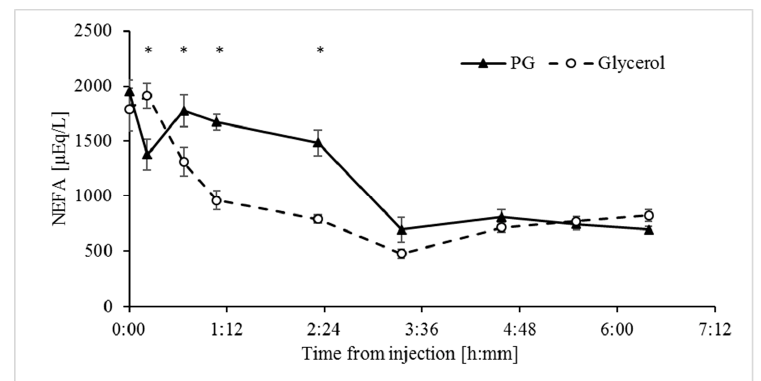
Figure 5. Non-esterified fatty acid (NEFA) response to the propylene glycol and glycerol treatments. Analyses indicate the effects of Treatment, Time, and Treatment × Time interaction (Table 1). * Significant difference at a = 0.00625 after Bonferroni correction. SEM = 53. Values represent mean ± SE.